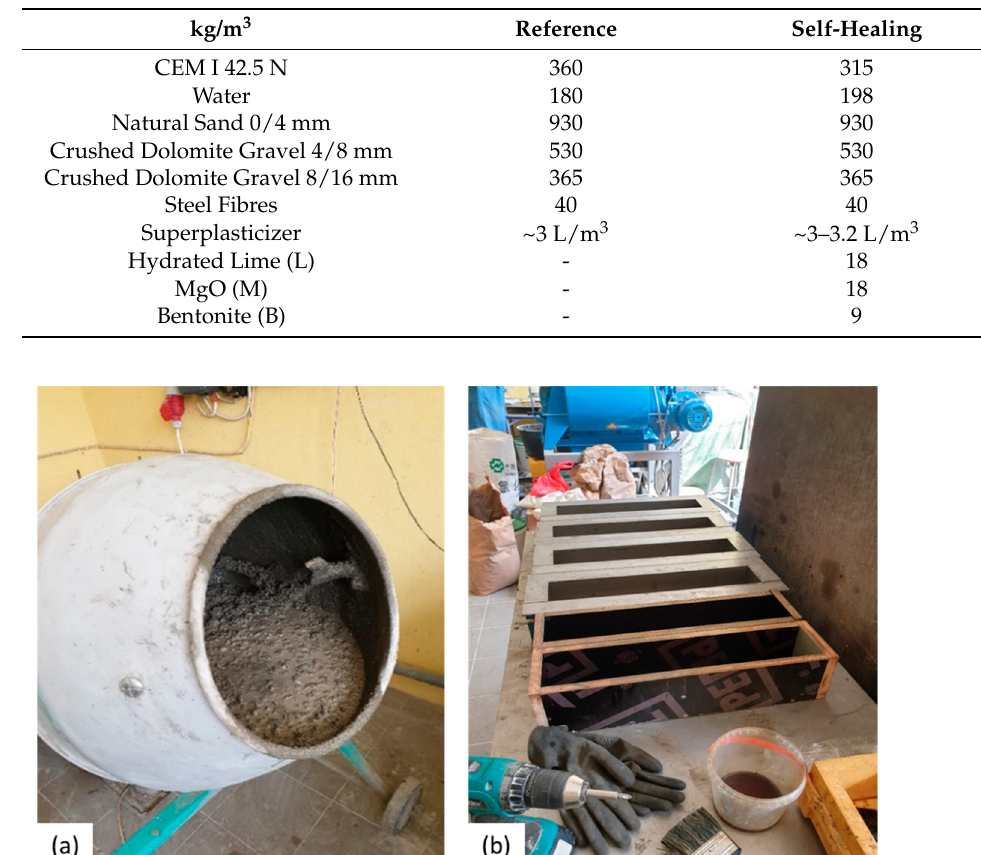
Table 2. Concrete mix design.